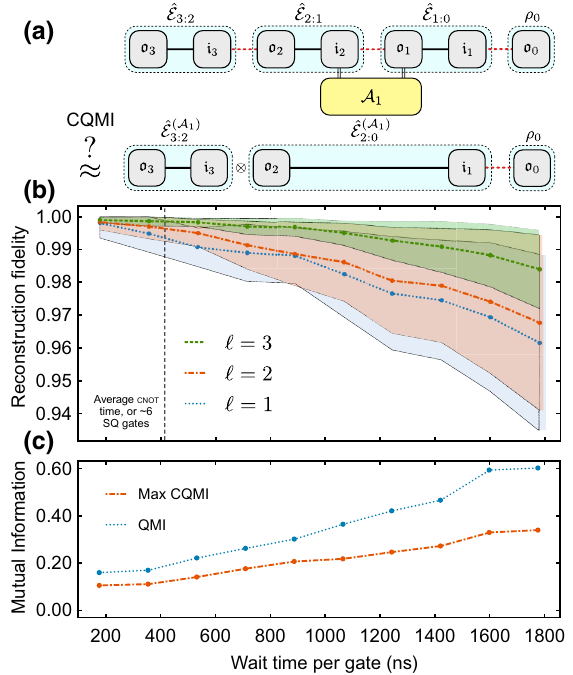
FIG. 8. The build-up of temporal correlations with increasing interaction time. (a) The CQMI quantifies the error in truncat- ing correlations beyond (cid:2) = 2 when conditioned on intermediate operations. (b) A four-step process is considered, with an increas- ing wait time after each gate. Using Markov orders (cid:2) = 1, (cid:2) = 2, and (cid:2) = 3, we quantify how each model reconstructs 100 random unitary sequences. The points indicate the average fidelity and the shaded regions indicate the standard deviation. (c) The QMI and CQMI both increase with the interaction time, bounding the breakdown of (cid:2) = 1 and (cid:2) = 2 models,